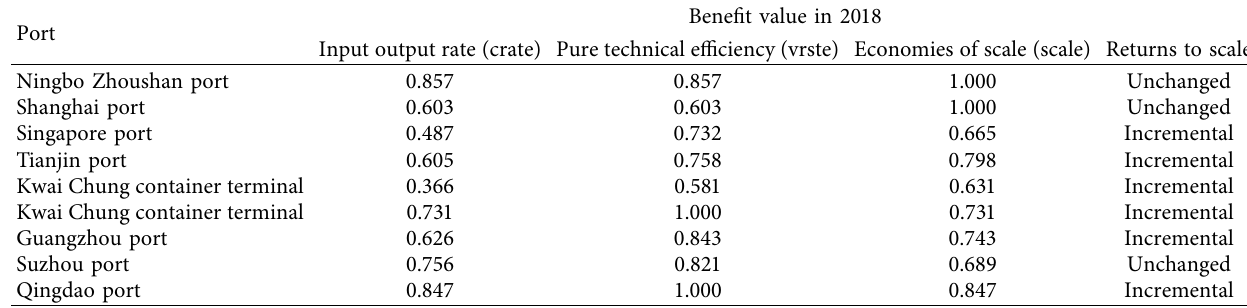
Table 7: Input-Output efficiency levels of nine ports in 2019.